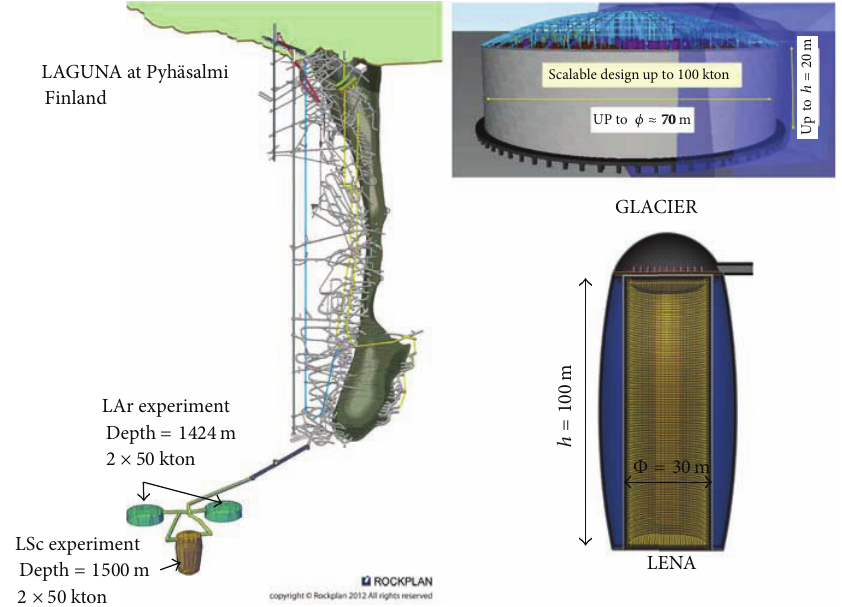
Figure 24: Schematic view of the Pyh¨asalmi mine and the GLACIER and LENA detector with their access